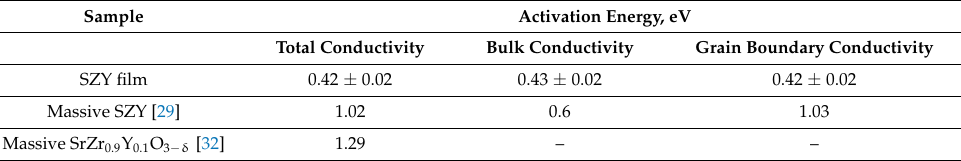
Figure 7. Temperature dependences of the total, bulk and grain boundary conductivities of the film and massive ceramic samples of SZY. Conductivity of massive SZY was reported in [29]. Table 3. Activation energies of total, bulk and grain boundary conductivities for the film and massive samples of SZY in dry